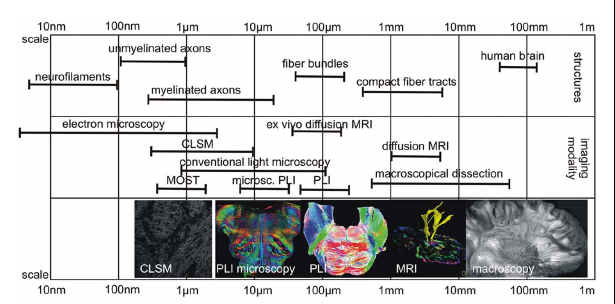
FIGURE 1 | Scales of anatomical structure and image modality. The image shows the different scales of anatomical structures of interest and the magnification of different image modalities, which can be used to study white matter architecture. Abbreviations: CLSM, confocal laser scanning microscopy; MOST, micro-optical sectioning tomography (Li et al.,